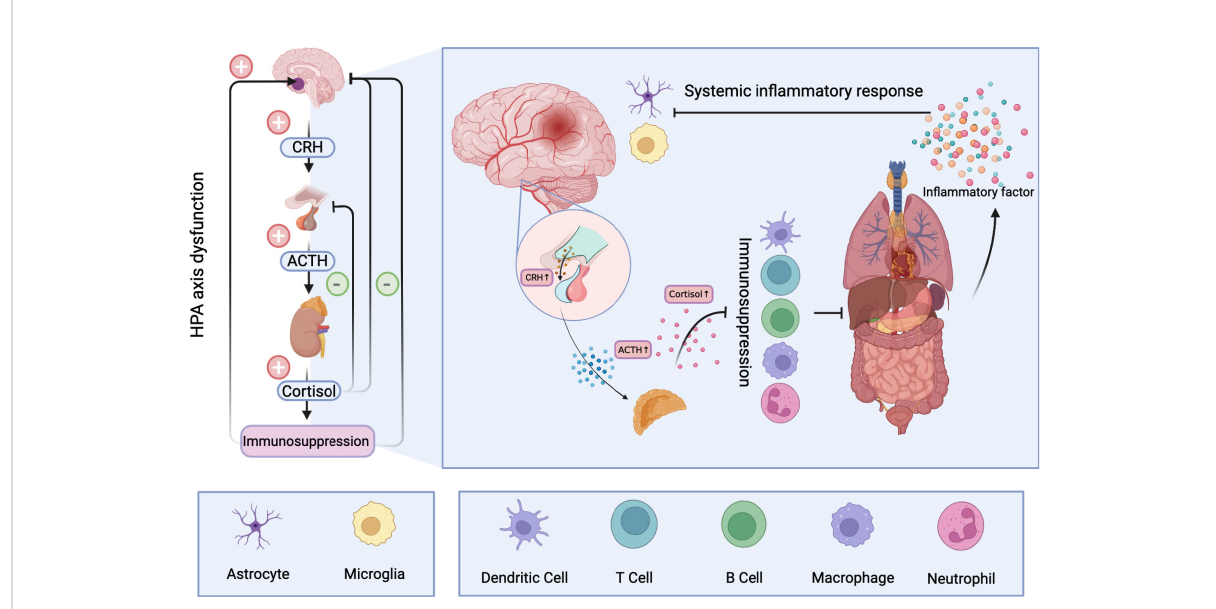
FIGURE 2 Hyperactivation of the HPA after ischemic stroke results in the release of large amounts of cortisol into the blood. Long-term elevated cortisol inhibits the immune system and can cause dysfunction and even apoptosis of immune cells. A dysfunctional immune system makes peripheral organs vulnerable to damage and produces a large number of in fl ammatory mediators, resulting in systemic in fl ammatory response. A storm of in fl ammatory factors follows. On the one hand, it can further stimulate the HPA, and on the other hand, it disrupts the normal function of nerve cells and has profound effects on the